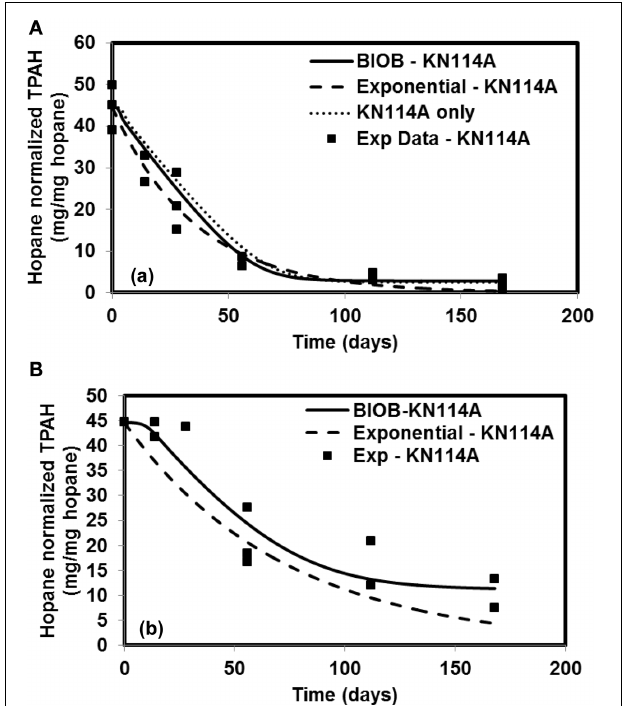
FIGURE 1 | Comparison of different model results and the experimental results for Eleanor Island (EL107) (A) Nutrient amended experiments (B) Natural attenuation.